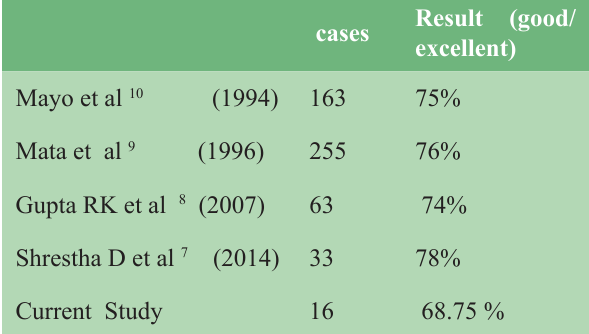
Comparisons of outcome with published results (according to The Merle d’Aubigné Hip Score)